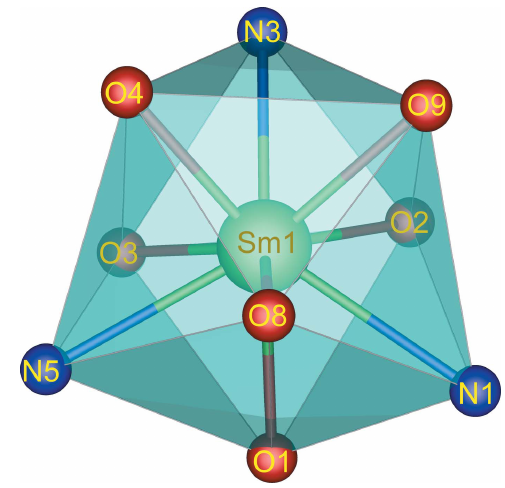
Figure 2 View of the distorted tricapped trigonal–prismatic coordination geometry of the central Sm III atom.